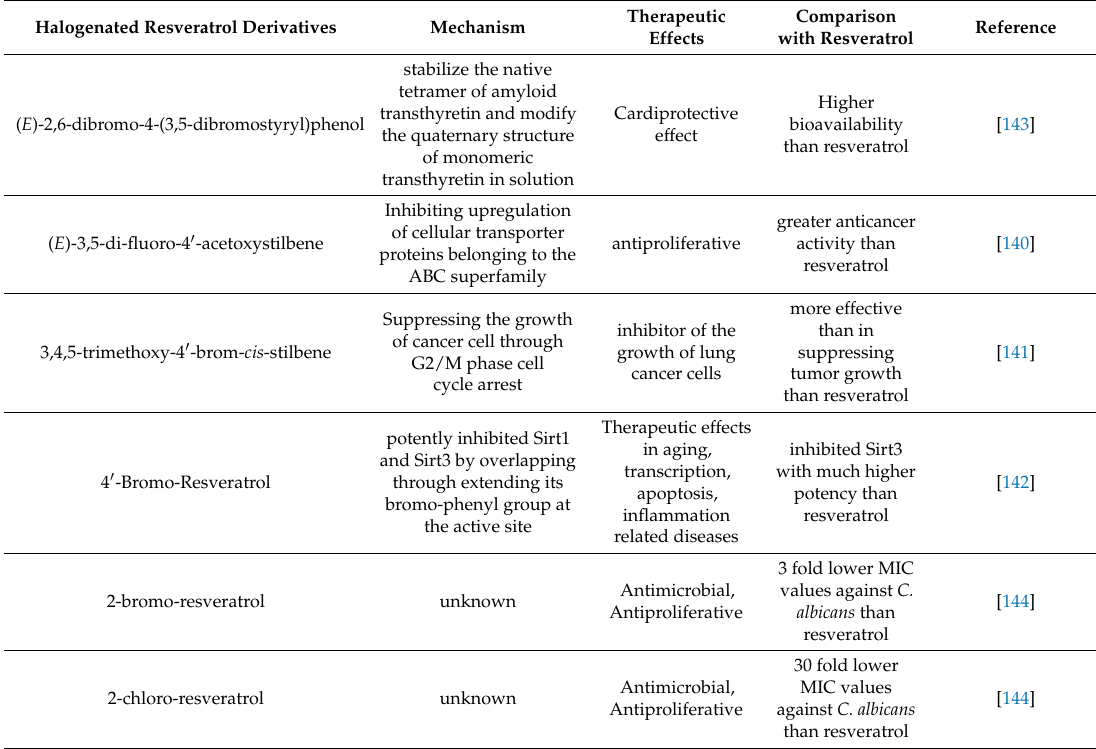
Table 3. Overview of Halogenated resveratrol derivatives, there therapeutic benefits, mechanism and effect on various